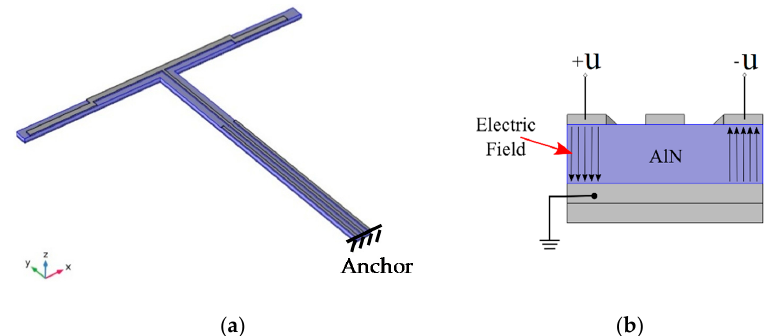
Figure 1. The T-shape structure ( a ) and the cross-section of the beam ( b ).